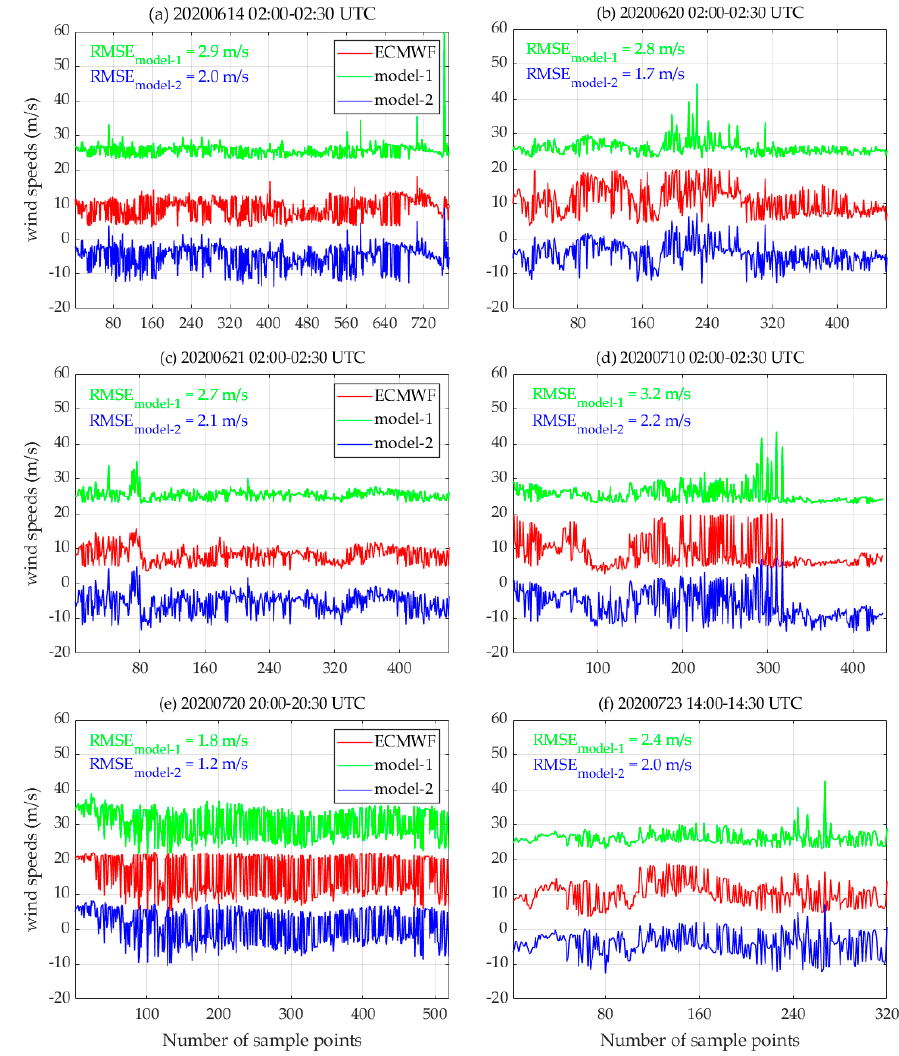
Figure 14. Comparison of sea surface wind speed estimation LES-based models and reference wind speed from ECMWF reanalysis data. Model-1 represents the double-parameter model in the LES method, and Model-2 represents the triple-parameter model. The X-axis represents the number of sampling points at a certain time of day, and the Y-axis represents the wind speed. ( a ) 02:00–02:30